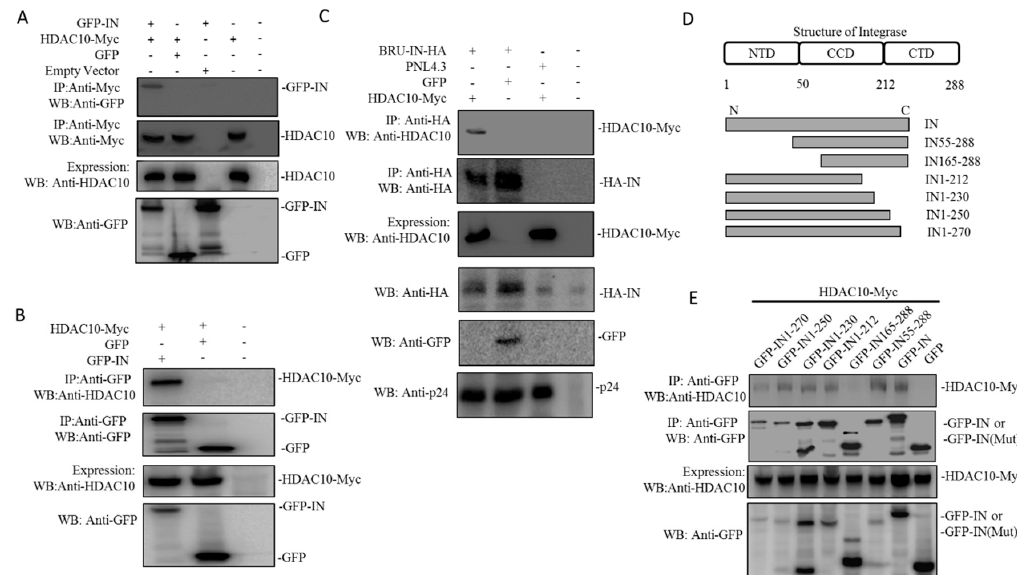
Figure 4. HDAC10 interacts with HIV-1 IN in co-transfected 293T cells. ( A ) GFP or GFP-IN was co-expressed with HDAC10-Myc in 293T cells for 48 h and cells were subjected to co-IP analysis by using anti-Myc antibody. Bound GFP-IN was detected by the anti-GFP antibody. ( B ) Above transfected 293T cells were subjected to co-IP by using rabbit anti-GFP antibody. Bound HDAC10 was detected by the anti-HDAC10 antibody. ( C ) HIV-1 Bru-IN-HA plasmid was co-expressed with HDAC10-Myc in 293T cells. Meanwhile, HIV-1PNL4.3 plus GFP plasmid was included as a control. Cells were subjected to co-IP analysis by using rabbit anti-HA antibody. Bound HDAC10 was detected by the anti-HDAC10 antibody. ( D ) The schematic of HIV-1 Integrase deletion mutant tagged with GFP. ( E ) GFP-IN wild type or its deletion mutant was co-expressed with HDAC10-Myc in 293T cells. Cells were subjected to Co-IP analysis by using anti-GFP antibody. Bound HDAC10 was detected by the anti-HDAC10 antibody. All the above expressions of HDAC10-Myc, GFP-INwt / mut, or IN-HA were detected by WB using anti-HDAC10, anti-GFP, or anti-HA antibody. Panels A – E show the presentative WB images from two independent experiments.